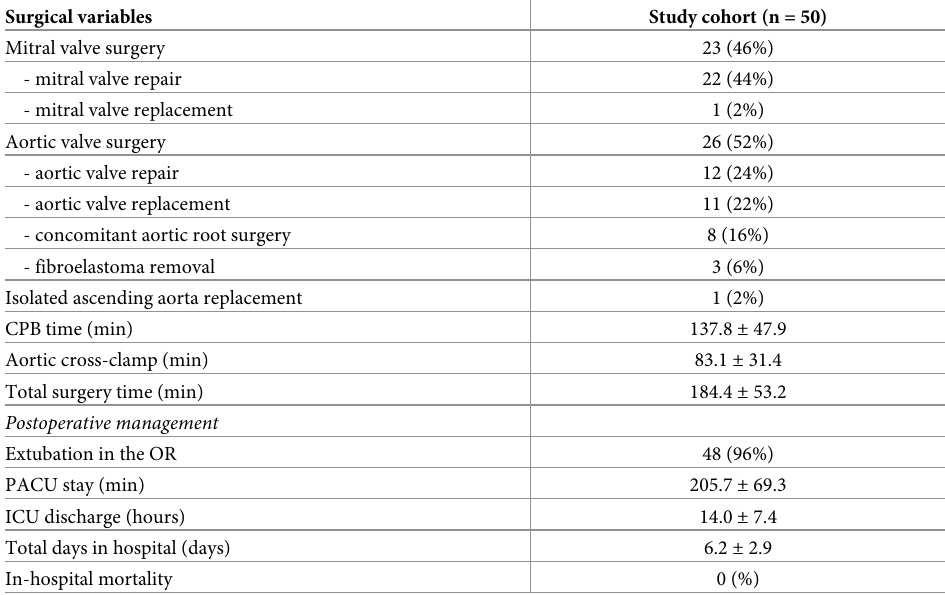
Table 2. Intraoperative and postoperative management. Values are presented as numbers (%) or as mean ± SD. CPB- cardiopulmonary bypass; ICU- intensive care unit; OR- operating room; PACU- post-anesthesia care unit. Surgical variables